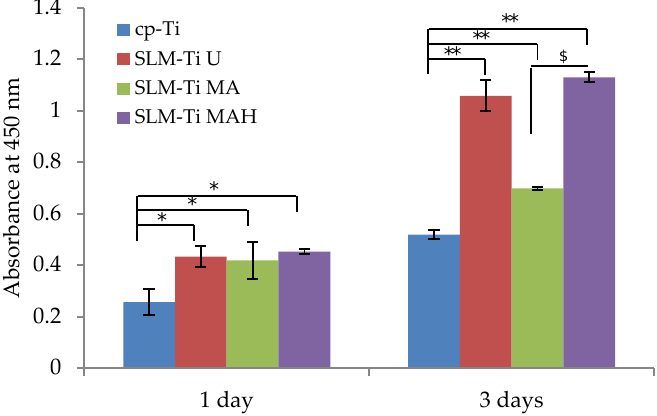
Figure 7. Viability of cells cultured on SLM-Ti that was untreated or treated with mixed acid and heat. Cells cultured on cp-Ti were tested as a control. After 1 and 3 days, the cell viability in each experiment or control sample was checked. All values are presented as the mean ± sd (n = 3), * different from cp-Ti, *p < 0.05; ** p < 0.01; $ different from SLM-Ti MA at p < 0.05.